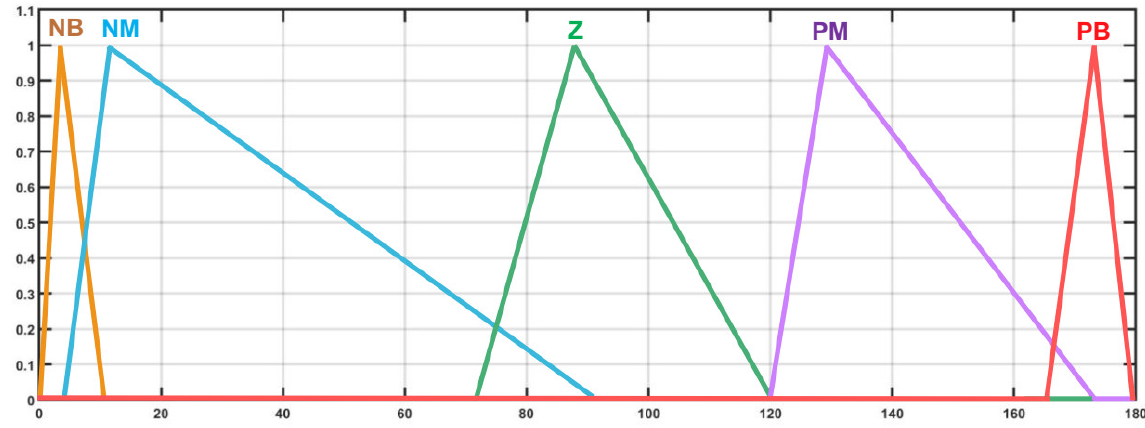
Figure 7. Membership functions of fuzzy controller linear output. Table 2. Membership functions of input and output.